Question: Looking at the figure, what chart type is it?
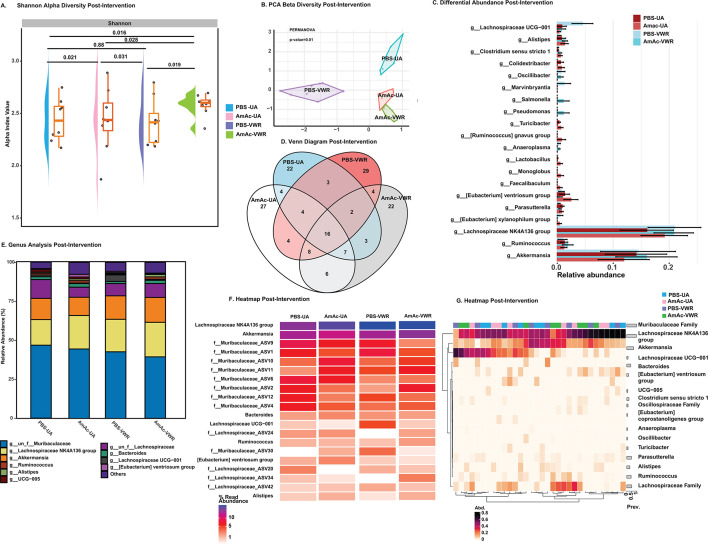
Answer: heatmap